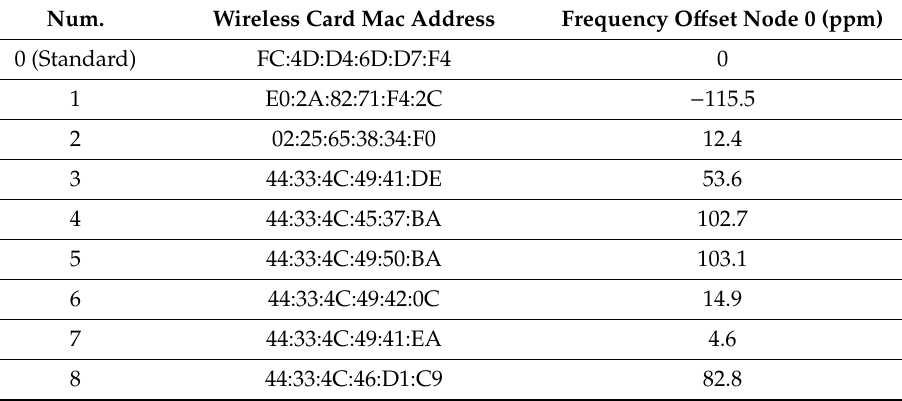
Table 2. Frequency offset of embedded Linux platforms.